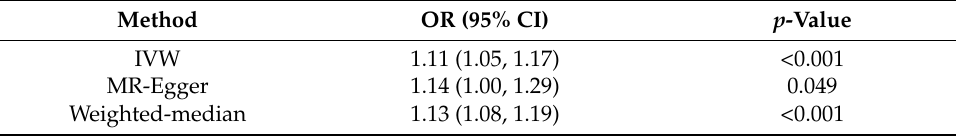
Table 2. Association of genetically predicted CAD with AF.